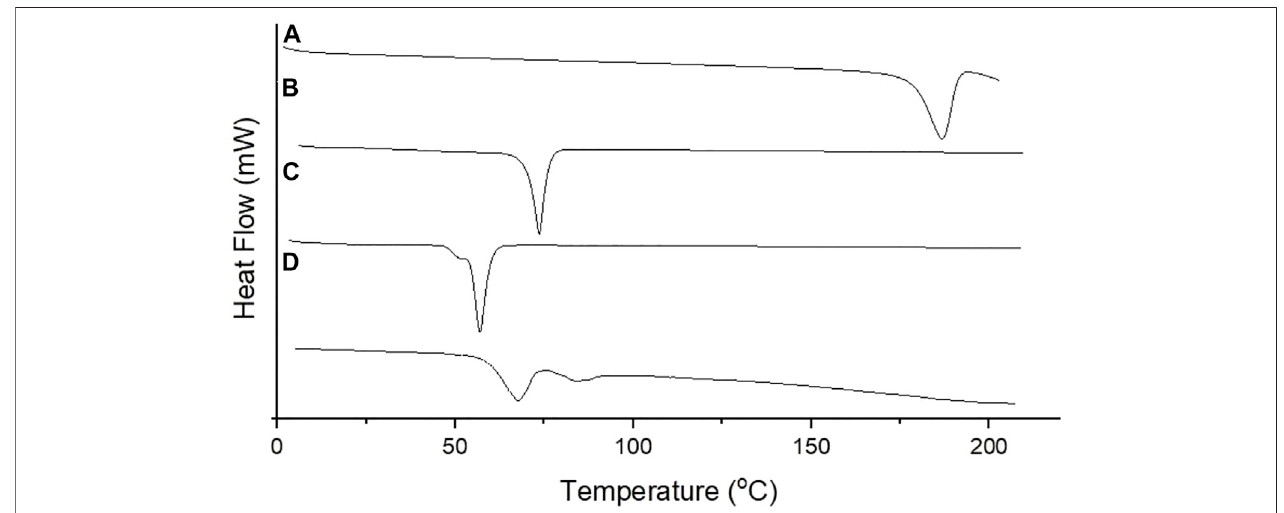
FIGURE 5 | DSC thermogram of (A) PGZ, (B) Compritol 888 ATO, (C) poloxamer 188, and (D) optimized PGZ-NLCs.